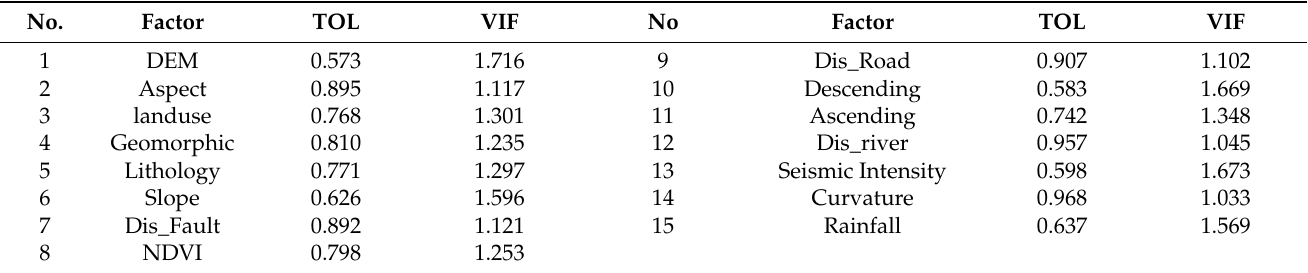
Table 5. Multicollinearity analysis of retained landslide susceptibility assessment